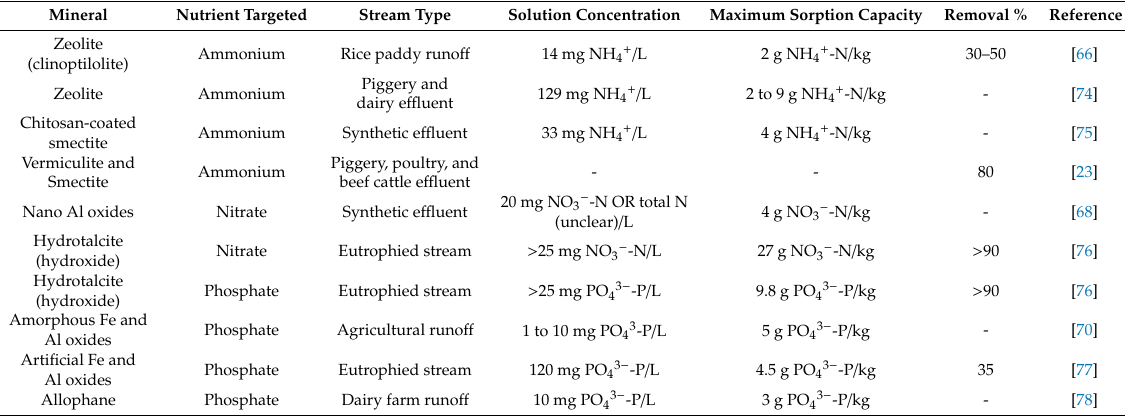
Table 1. Performance of various geological minerals removing ammonium, nitrate, and phosphate from waste